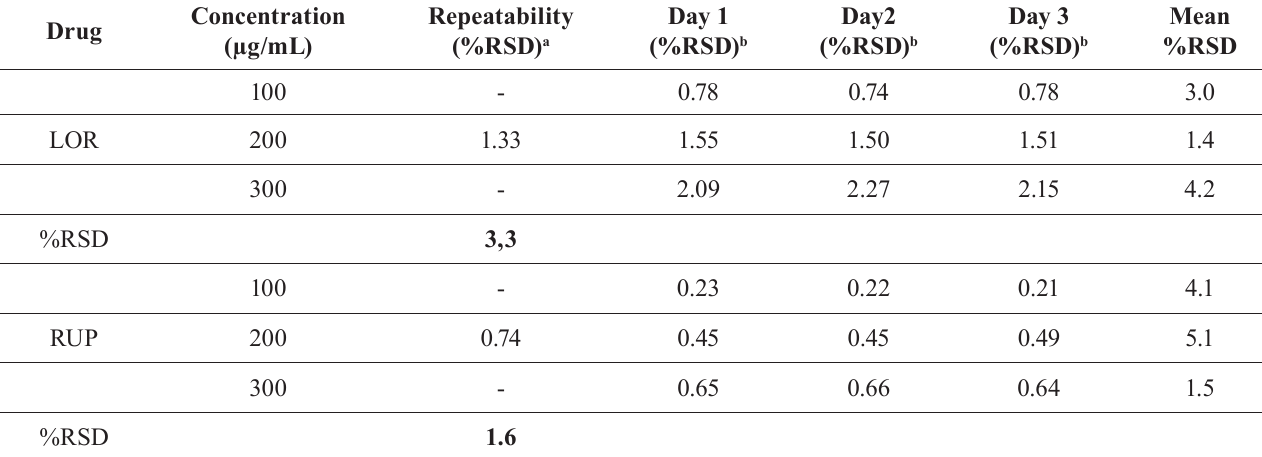
TABLE IV - Precision (repeatability and intermediate precision) for LOR, and RUP